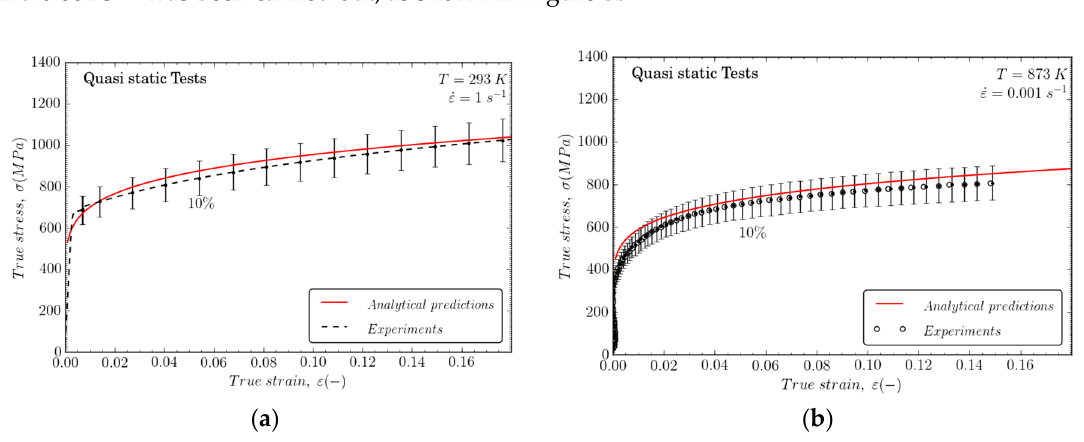
( d ) Figure 9. Comparisons between analytical predictions of the constitutive model and experiments at 1900 s − 1 and ( a ) T 0 = 293 K; ( b ) T 0 = 323 K; ( c ) T 0 = 423 K; and ( d ) T 0 = 523 K. Moreover, it is remarkable that the Johnson–Cook model exhibits the capability for properly describing the rate sensitivity of the material, as shown in Figure 10a. The material temperature sensitivity is also well defined by the model predictions, as shown in Figure 10b. These facts are of primary relevance for aeronautical applications where Haynes 282 is widely used.